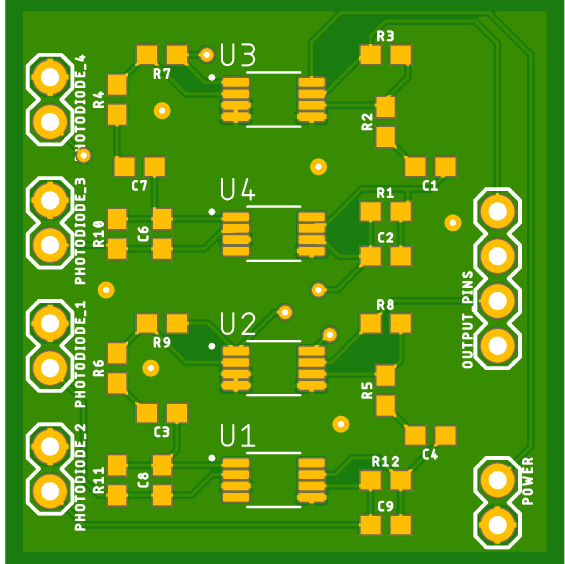
Figure 11. Optical